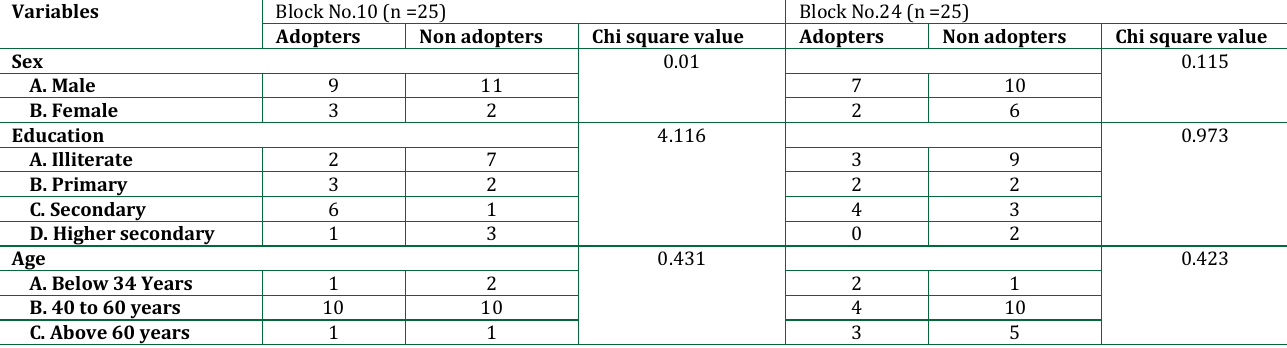
Table 3: Adoption status of management practices among different socioeconomic characteristics Variables